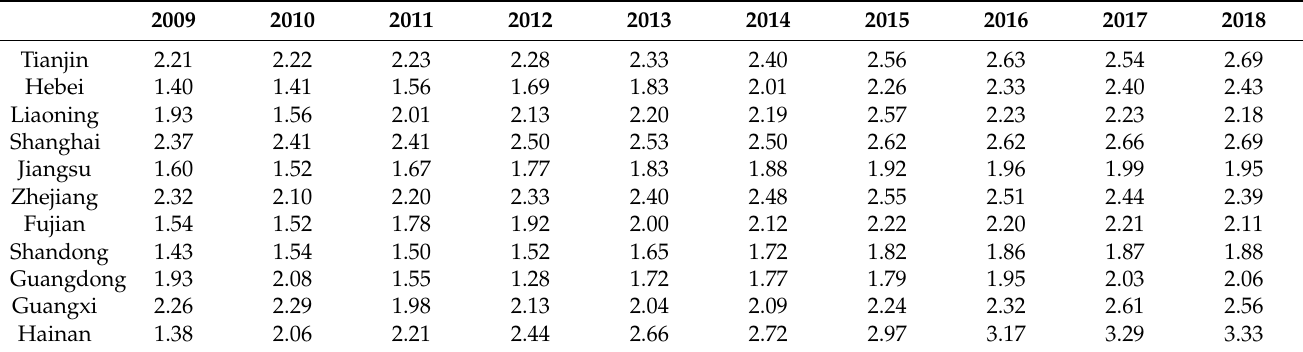
Table 1. Economic efficiency value of financial support from 2009 to 2018.